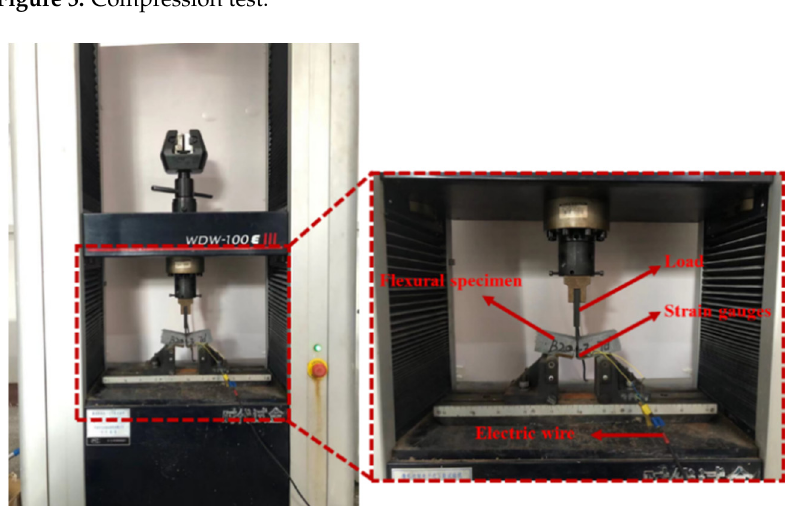
Figure 5. Compression test.